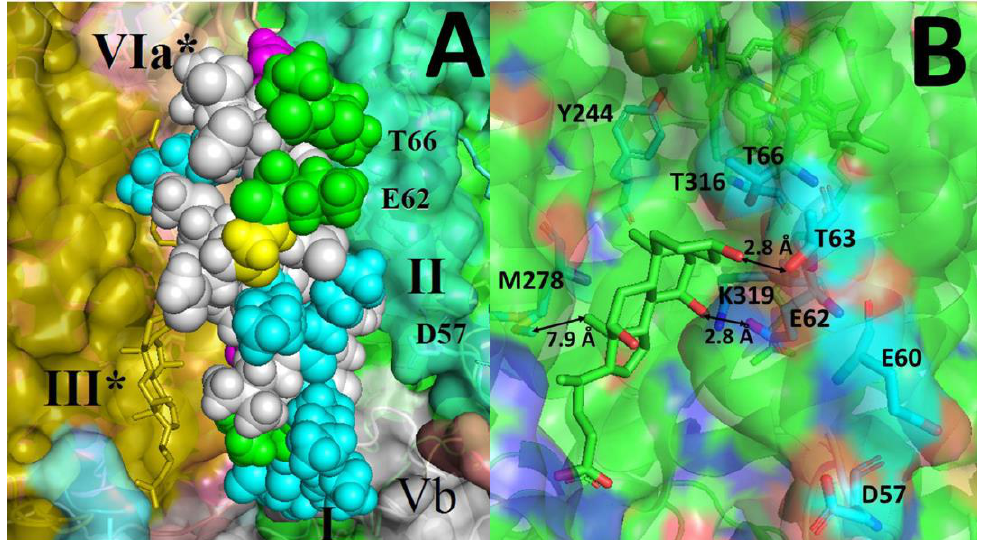
Figure 9. Structural view on the possibility of K-channel inhibition by BABS ligands. ( A ) Superposition of the P4 peptide secondary structure on the 3D structure of BABS. The structure of the dimeric mitochondrial enzyme in the region of BABS is shown (based on [63]). Side view. The inner (matrix) surface of the membrane is at the bottom. Subunits I (green), II (cyan) and Vb (grey) are indicated, as well as subunits III (brown) and VIa (wheat) from the neighboring monomer (marked with an asterisk, ∗ ). The peptide P4 molecule is depicted in the same conformation as in Figure 6A and inscribed in a hydrophobic gap between subunits I, II, and VIa, which opens onto the viewer. The residues belonging to the CRAC motif and Gly are marked in color as in Table 1 and Figure 6. ( B ) The location of BABS relative to the proton channel K. Compared to panel A, the view is zoomed in and slightly rotated. A bound cholate molecule is shown in the hydrophobic cavity. The most important residues are designated, and their structure is shown by sticks. Cyan color represents protonatable residues of subunit II near the entrance to the K-channel. The oxygen and nitrogen atoms are colored red and blue, respectively. The distances between some groups are given (double-sided arrows).